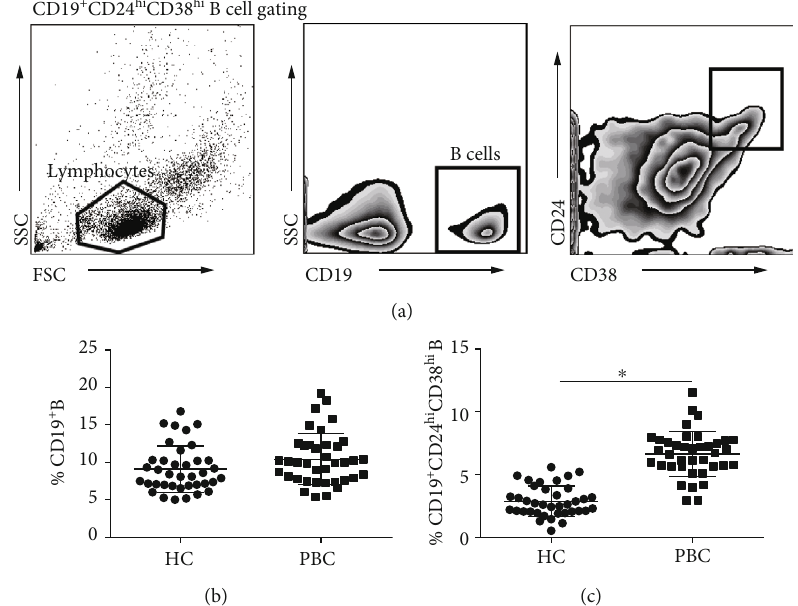
Figure 1: Frequencies of CD19 + CD24 hi CD38 hi B cells were upregulated in the peripheral blood of PBC patients. (a) The gating strategy for CD19 + CD24 hi CD38 hi B cells by fl ow cytometry. (b) Statistical analysis of circulating CD19 + B cell frequencies in PBC patients and HC subjects. (c) Statistical analysis of circulating CD19 + CD24 hi CD38 hi B cell frequencies in PBC patients and HC subjects; ∗ P < 0 : 05